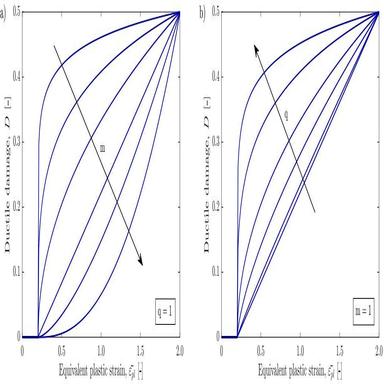
Effect of m and q parameters on the damage accumulation model: (a) q = 1 and variable m; (b) m = 1 and variable q. In both cases εth = 0.2 and Dcr = 0.5.